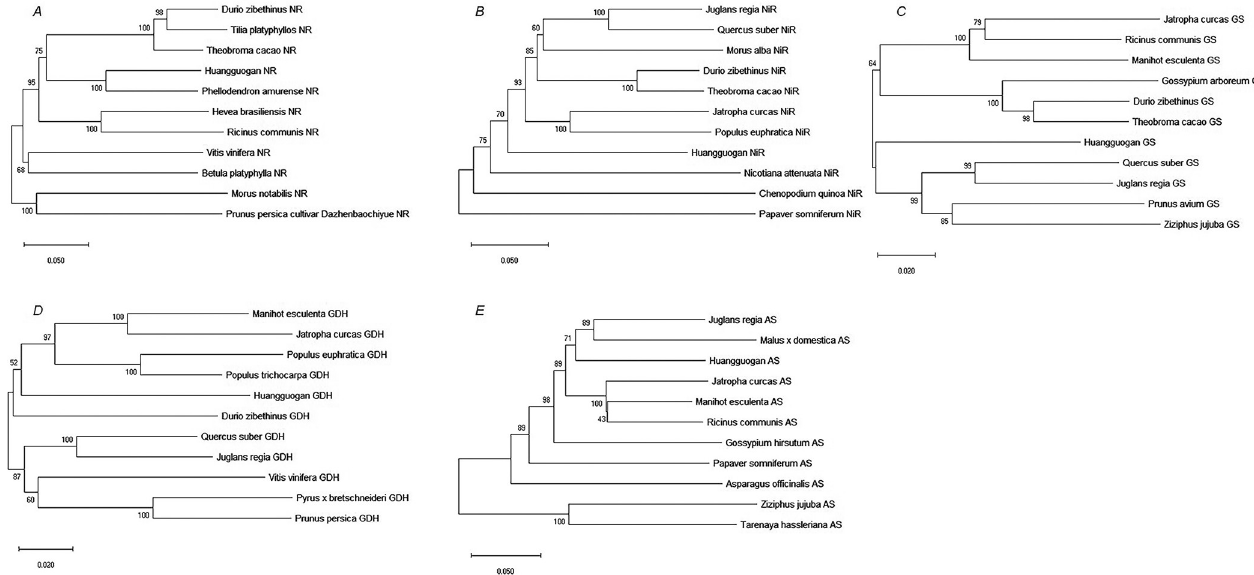
Fig 1. Phylogenetic tree of HgNR , HgNiR , HgGS , HgGDH , and HgAS genes. NR:Nitrate reductase (A), NiR:nitrite reductase (B), GS:glutamine synthetase (C), GDH:glutamate dehydrogenase (D), and AS:asparagine synthetase (E). Note: The number of nodes is bootstrap value, and the number of branches is the evolutionary distance. Sequences shown are from NCBI sequence database. Sequences of NR, NiR, GS, GDH, and AS are referred to in S1 Table.